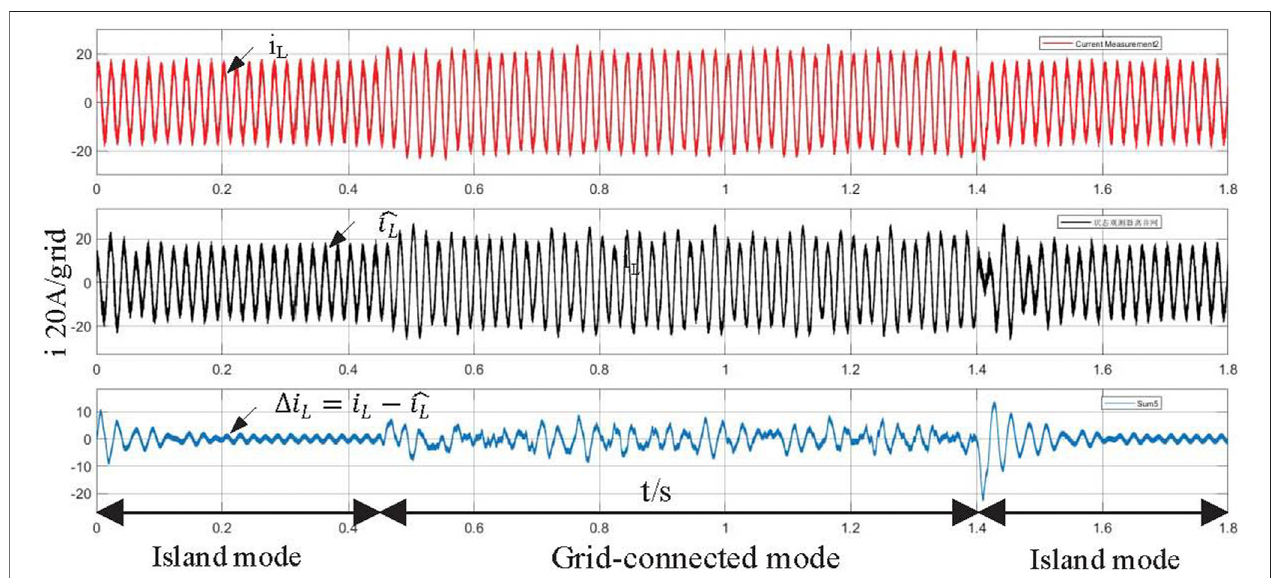
FIGURE 11 | Simulation waveform of real inductor current i L , observed inductor current (cid:15) i L and error Δ i L .